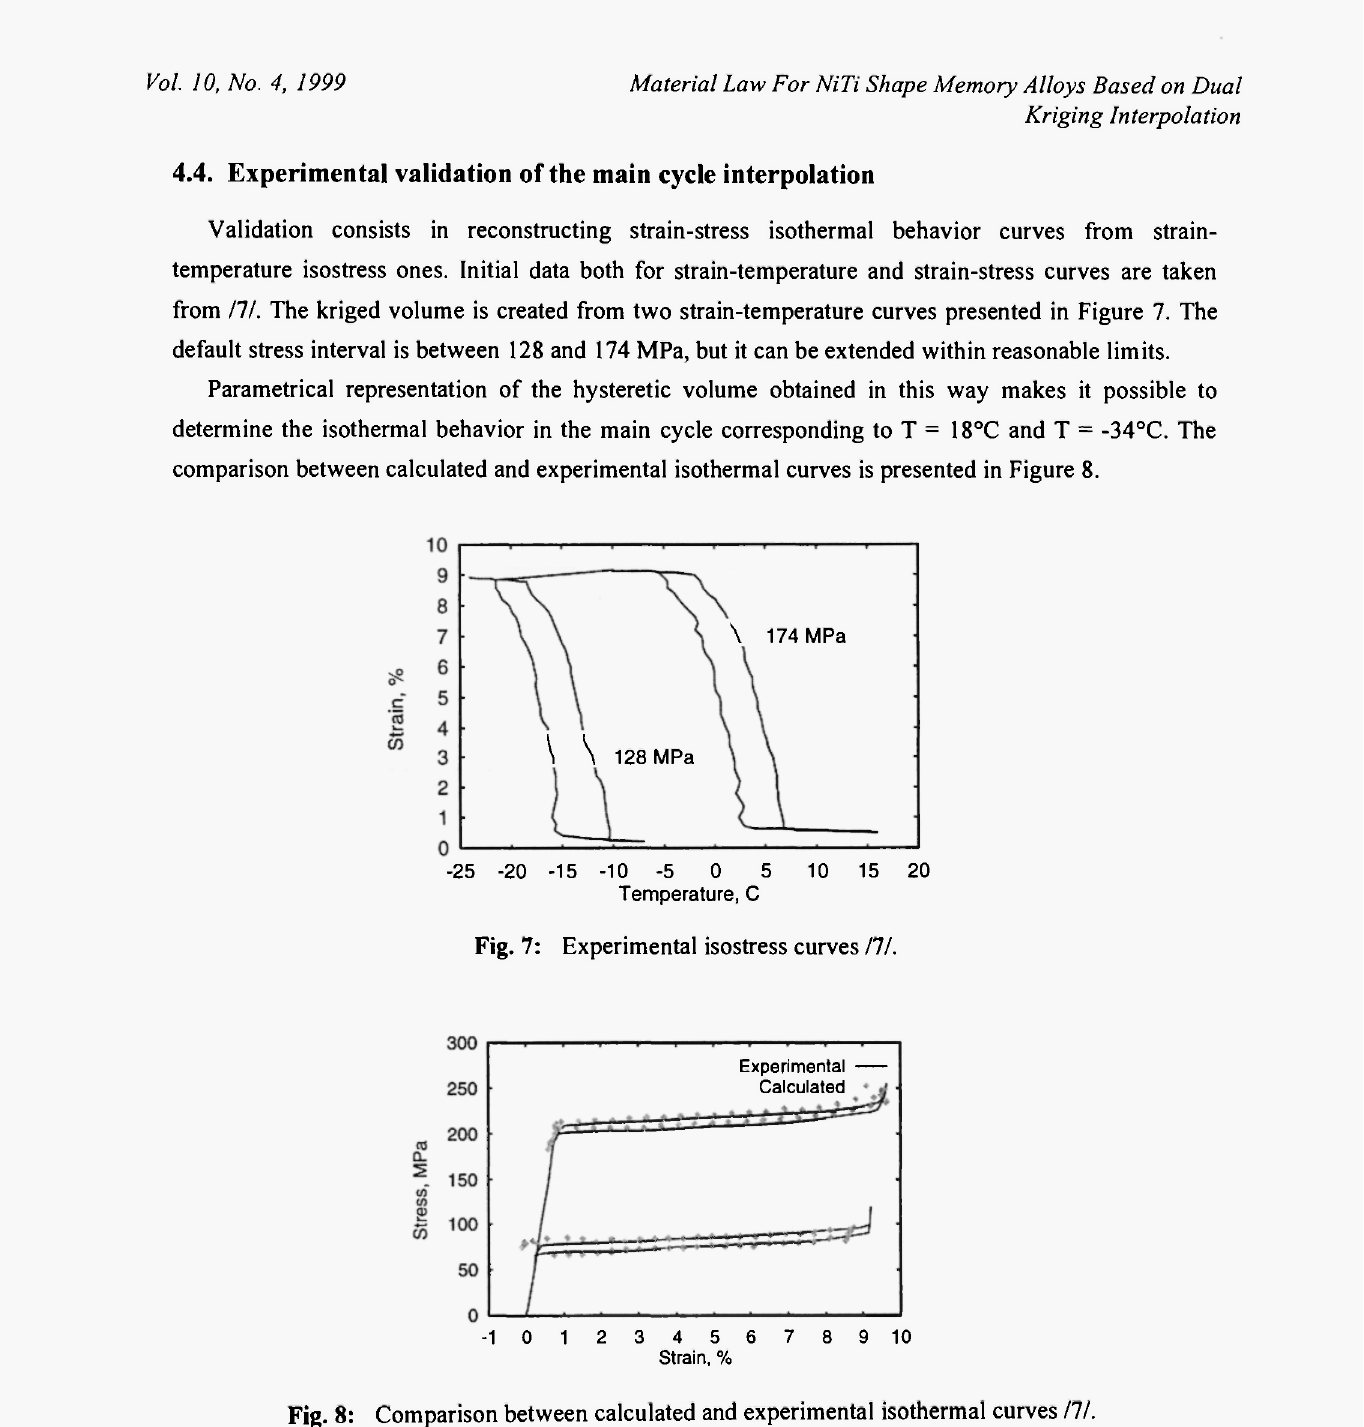
Fig. 7: Experimental isostress curves 111.